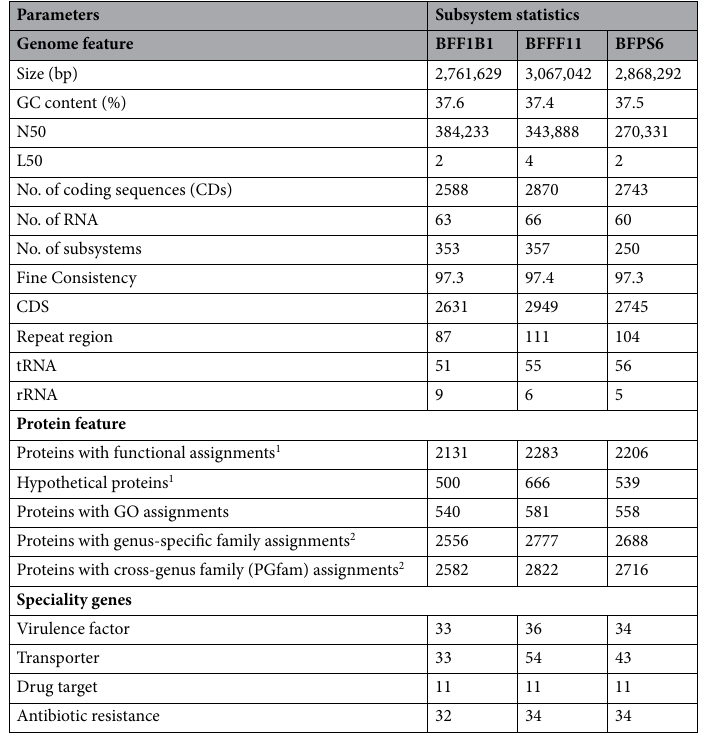
Table 1. General genomic features of the E. faecalis strains BFFF11, BFF1B1 and BFPS6 obtained from RAST and PATRIC analysis. 1 values indicate with KEGG annotation. 2 Proteins with PATRIC genus-specific family (PLfam) and cross-genus-specific family (PGfam) assignments (Brettin et al . 47